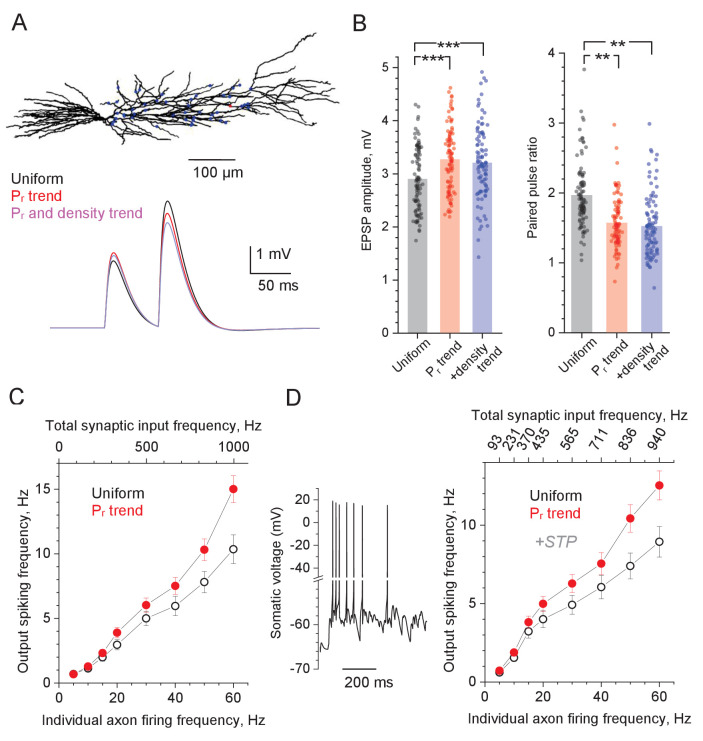
Computer simulations of CA1 pyramidal cell with stochastic excitatory synapses.(A) Diagram, NEURON model of a reconstructed CA1 pyramidal cell (Migliore et al., 1999) (ModelDB 2796; variable time step dt, t = 34°C). 50 excitatory inputs (blue dots) generate bi-exponential conductance change (rise and decay time, 1 ms and 20 ms, respectively) stochastically, in accord with Pr. Traces, simulated somatic response to paired-pulse stimuli (50 ms apart), with Pr distributed either uniformly randomly (black), or in accord with the distance-dependent trend (as in Figure 1C; red), and both Pr and synaptic density trends (as in Figure 2E, blue; same average Pr = 0.36 ). (B) Summary of simulation tests in (A); dots, individual runs (n = 100); bars, mean EPSP amplitude (left, mean ± SEM: 2.90 ± 0.060, 3.27 ± 0.061, 3.20 ± 0.068, for the three conditions, respectively, as indicated) and paired-pulse ratios (right, mean ± SEM: 1.96 ± 0.047, 1.57 ± 0.036, 1.52 ± 0.0437, notation as above) are shown; ***p<0.005. (C) Input-output spiking rate relationship over the physiological range of input firing frequencies (per axon, bottom axis; total, top axis); hollow circles, uniform distribution of Pr; solid symbols, Pr follows the distance-dependent trend (as in Figure 1C); mean ± SEM are shown (n = 100 simulation runs). (D) Trace: A characteristic cell spiking burst (model as in A) in response to a Poisson-process afferent spiking input (~50 Hz per synapse) incorporating the experimental kinetics of short-term plasticity (STP) at CA3-CA1 synapses (Mukunda and Narayanan, 2017) (see Figure 4—figure supplement 1C–F for detail). Graph: Input-output spiking rate relationship across the physiological range of average input firing frequencies, with experimental STP incorporated; other notations as in (C); the top abscissa scale is nonlinear because STP affects average Pr in a biphasic, non-monotonous manner (see Figure 4—figure supplement 1C).Figure 4—source data 1.Original data readout for Figure 4A–D and Figure 4—figure supplement 1A–F.